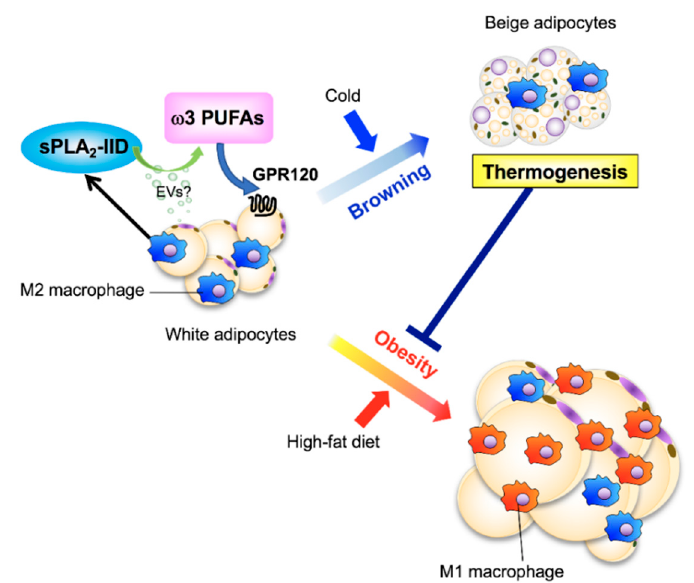
Figure 2. The role of sPLA 2 -IID expressed in M2 macrophages in adipocyte browning and adaptive thermogenesis. sPLA 2 -IID releases ω 3 PUFAs, which then act on GPR120 to drive the thermogenic and anti-inflammatory programs toward metabolic health. Impairment of this sPLA 2 -IID-driven lipid pathway leads to impaired thermogenesis and exacerbated diet-induced obesity.